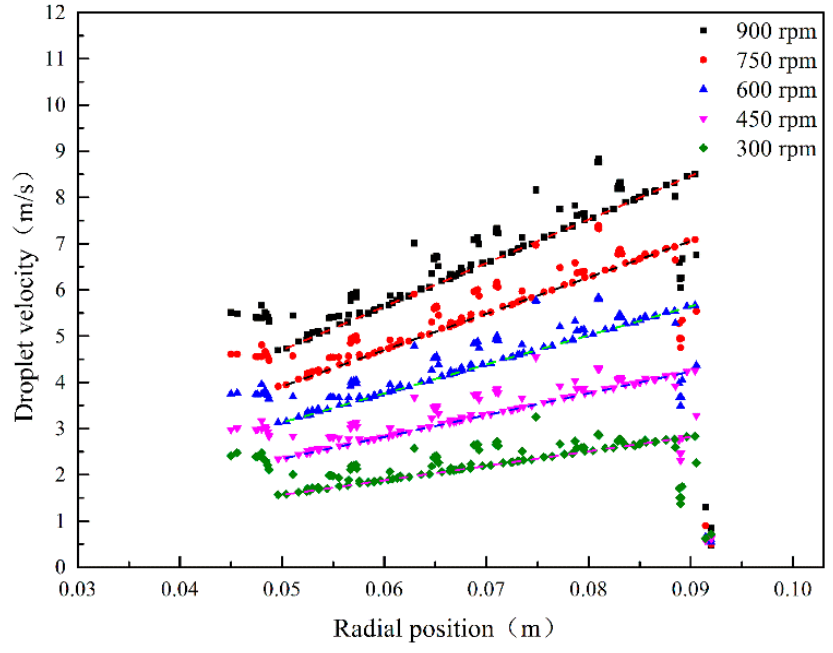
Figure 8. The e ff ect of rotating speed on droplet velocity in the packing zone. Figure 8. The effect of rotating speed on droplet velocity in the packing zone.